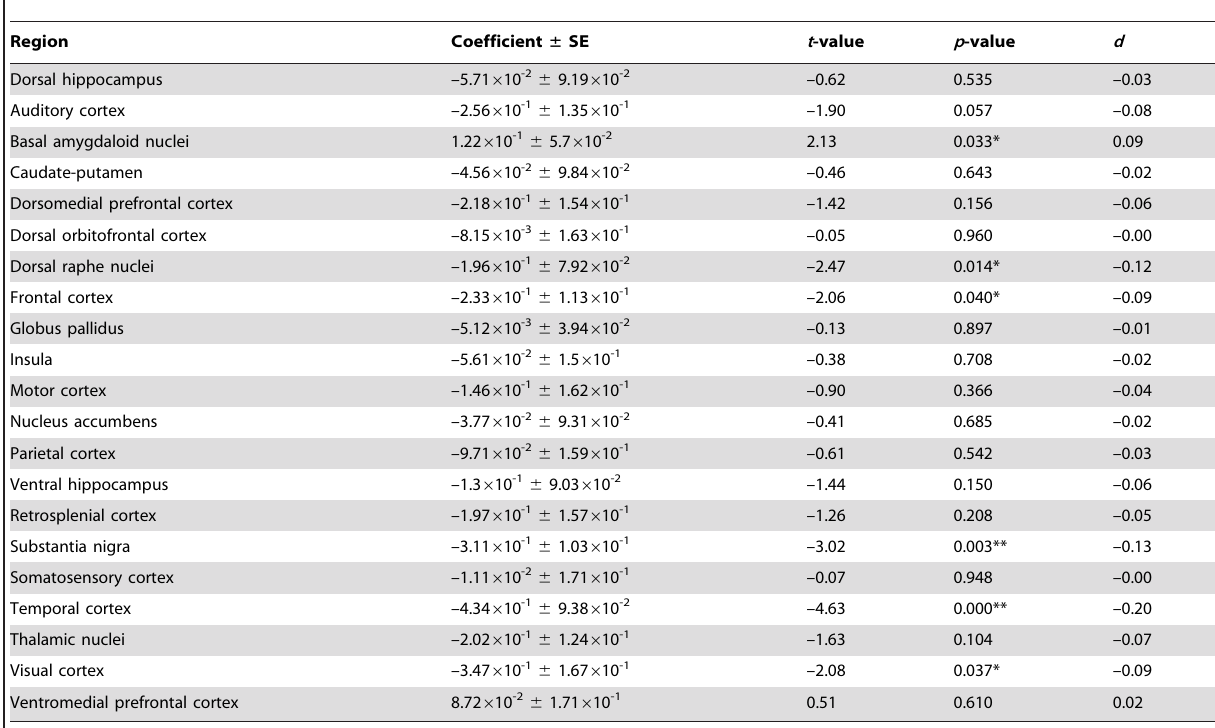
Table 1. Cocaine-induced brain activation: results from seed-based generalized least squares fit of pharmacological MRI response.